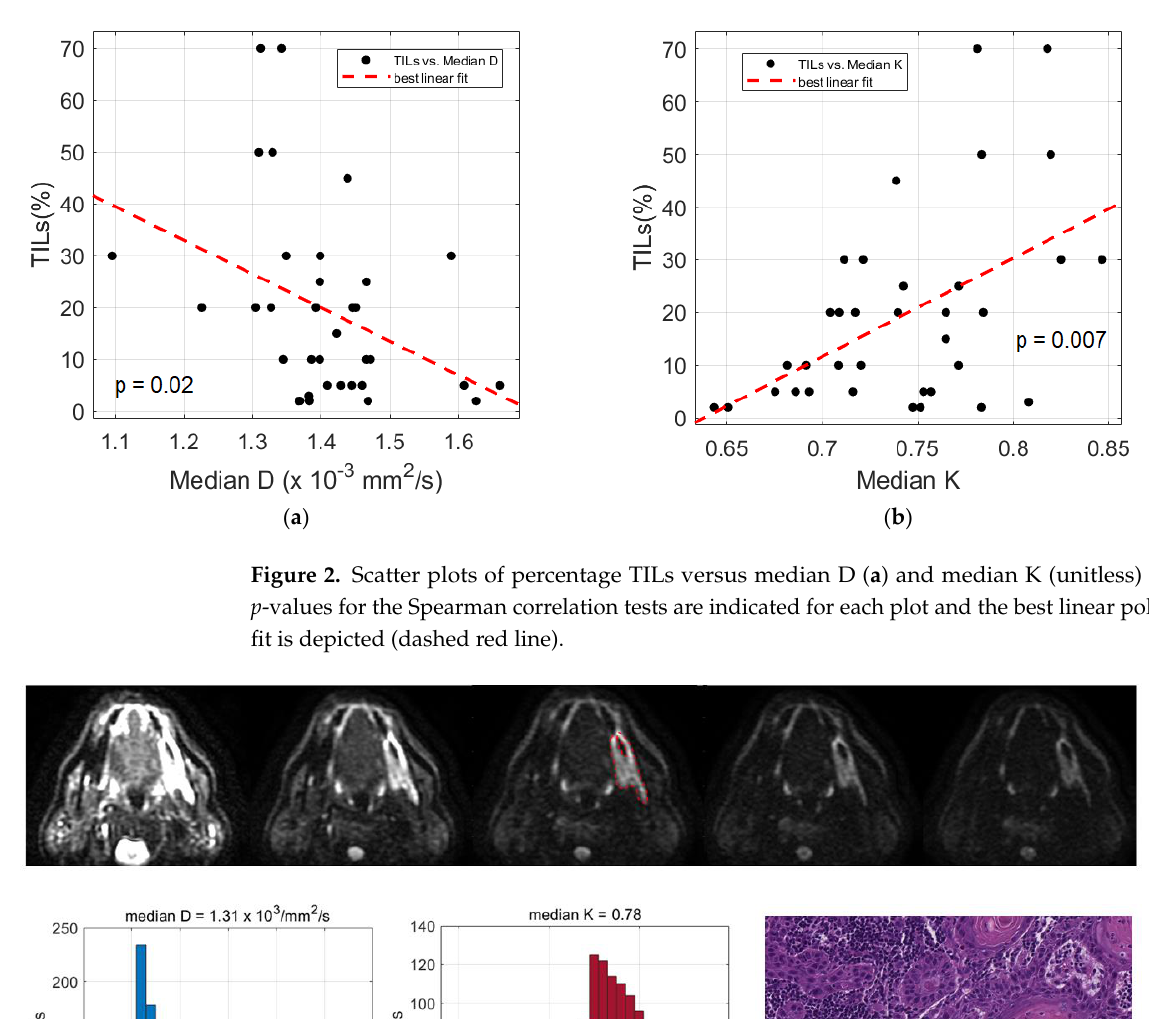
Figure 4. Top (from left to right): central section of a cheek tumor in a 68-year-old man on diffusion-weighted images obtained with increasing values: b = 0, 500, 1000, 1500 and 2000 mm 2 /s; the user-defined lesion contour is in red. Bottom (from left to right): histograms of D and K values derived from the entire tumor volume, indicating slightly restricted water molecule diffusivity and